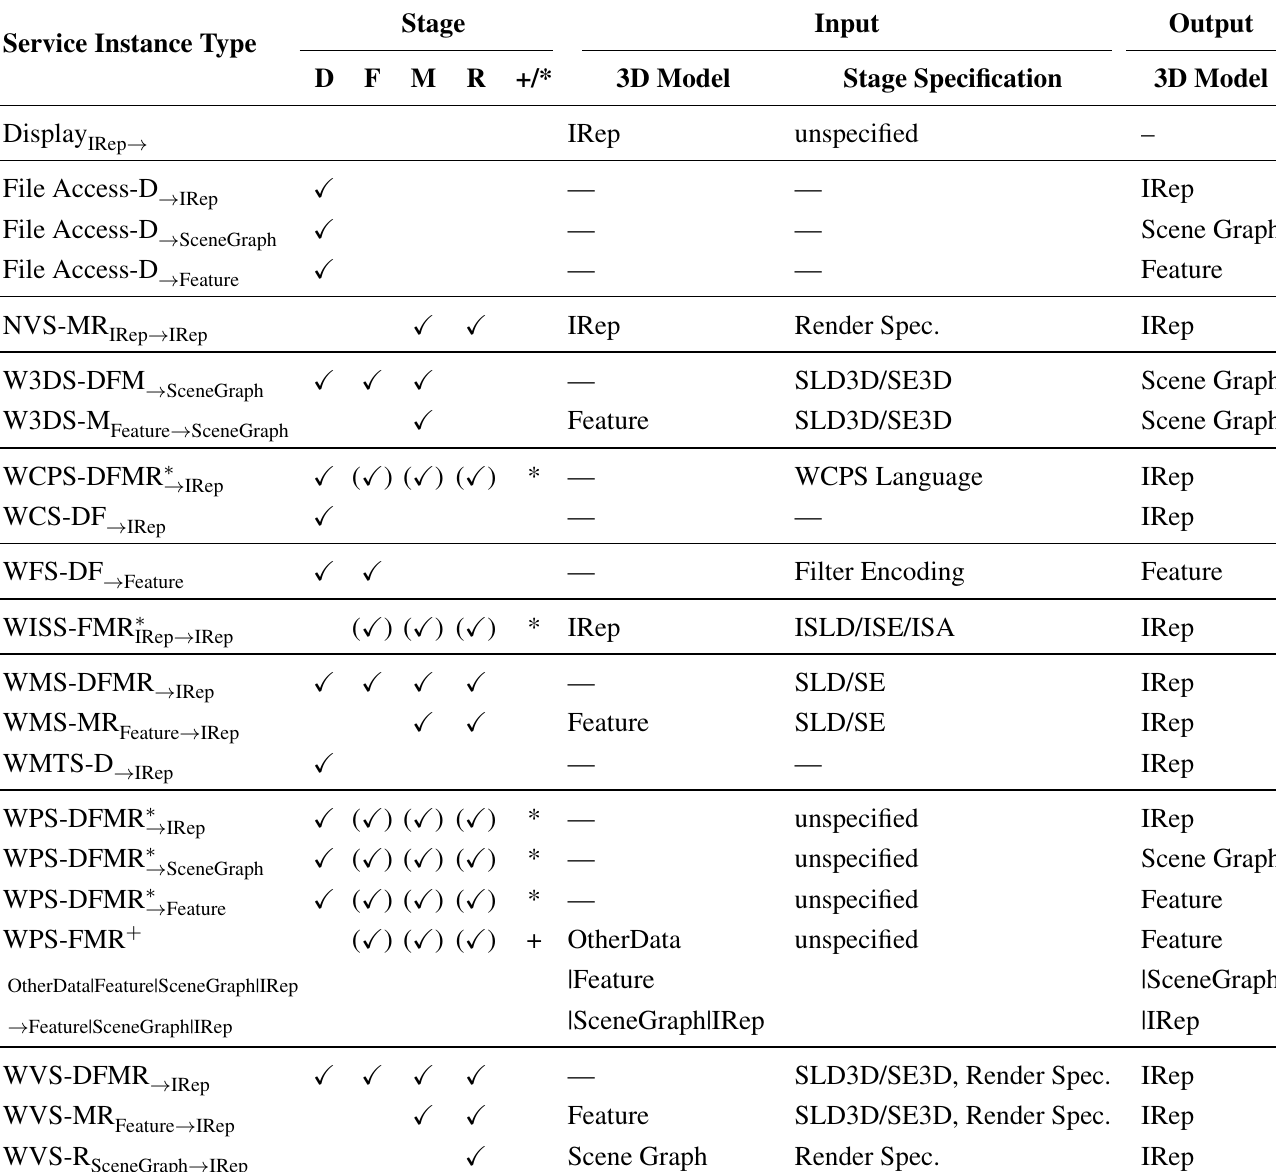
Table 5. Categories of service instances suitable for composing generalized visualization pipelines differentiated according to implemented stages, input and